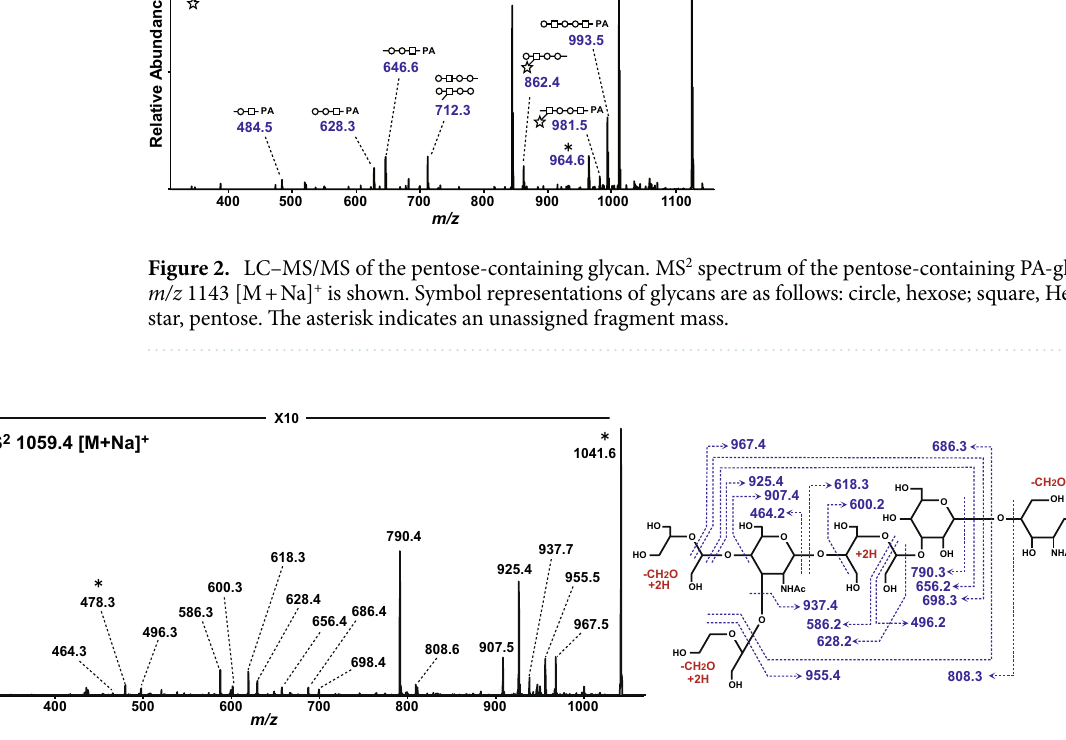
Figure 3. LC–MS/MS of the pentose-containing glycan after periodate cleavage. The periodate oxidation products were analyzed by LC–MS/MS. MS 2 spectrum of the periodate-cleaved hexasaccharide at m/z 1059 [M + Na] + (Hex 3 HexNAc 2 Pen 1 -PA + 3 × 2H, − 3 × CH 2 O) in positive ion mode MS is shown. The MS 2 fragment ions were assigned as shown in the illustration. Assignments were based on a combination of results from other structural analyses. Note, it was not possible to determine whether the linkage positions of the terminal hexose and pentose residues was C-3 or C-4, respectively. Asterisks indicate dehydrated